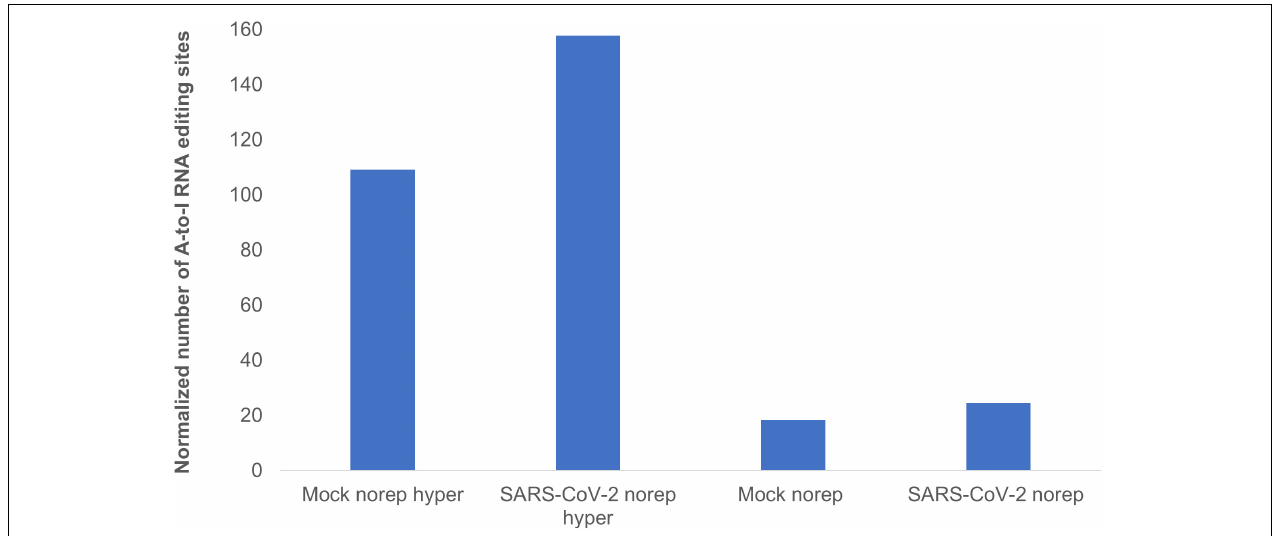
FIGURE 3 | A-to-I hyper editing sites are more frequent in SARS-CoV-2 infected cells compared to mock. Presented here are the numbers of A-to-I RNA editing sites detected in SARS-CoV-2 or Mock samples in total, normalized to total counts. Norep: non-repetitive editing sites, norep hyper: hyper non-repetitive editing sites. The number of non-repetitive hyper editing sites is significantly higher in SARS-CoV-2 samples compared to mock ( P -value = 0.0371), and the number of non-repetitive sites is similar in both SARS-CoV-2 and mock ( P -value > 0.05).